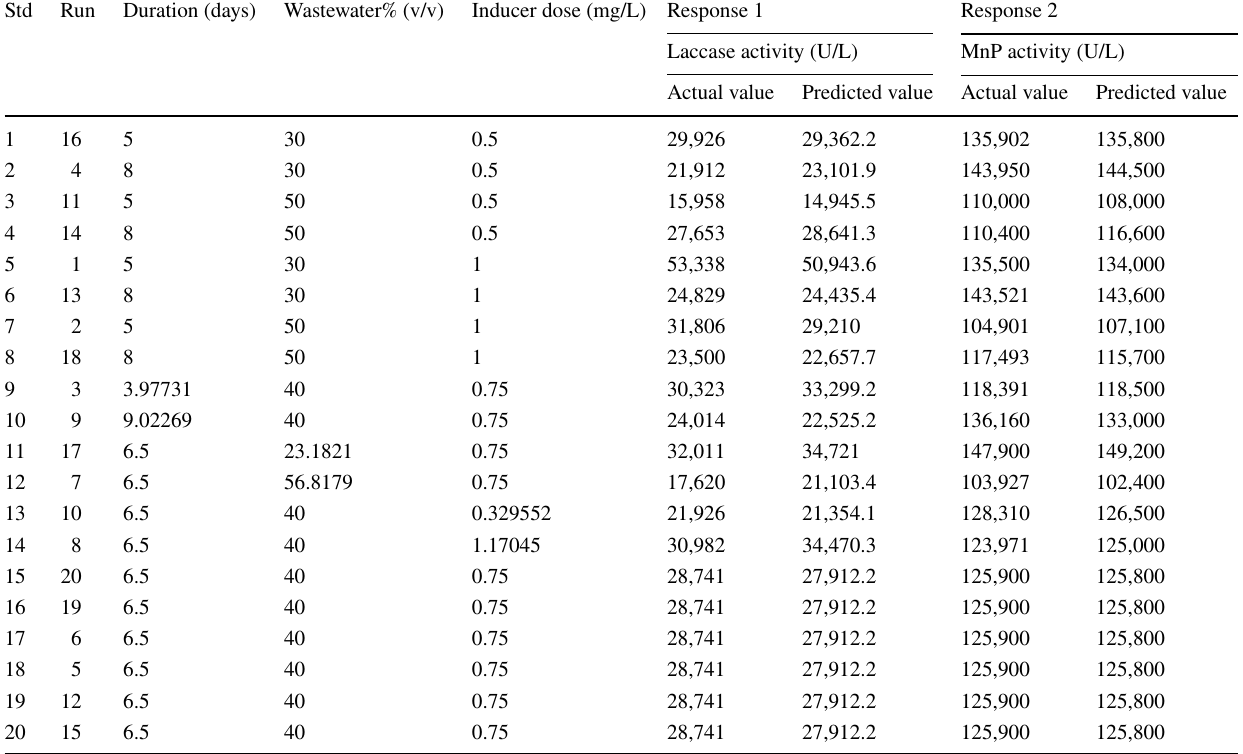
Table 2 Predicted and actual values of optimized parameters for laccase and MnP production by CCD matrix Std Run Duration